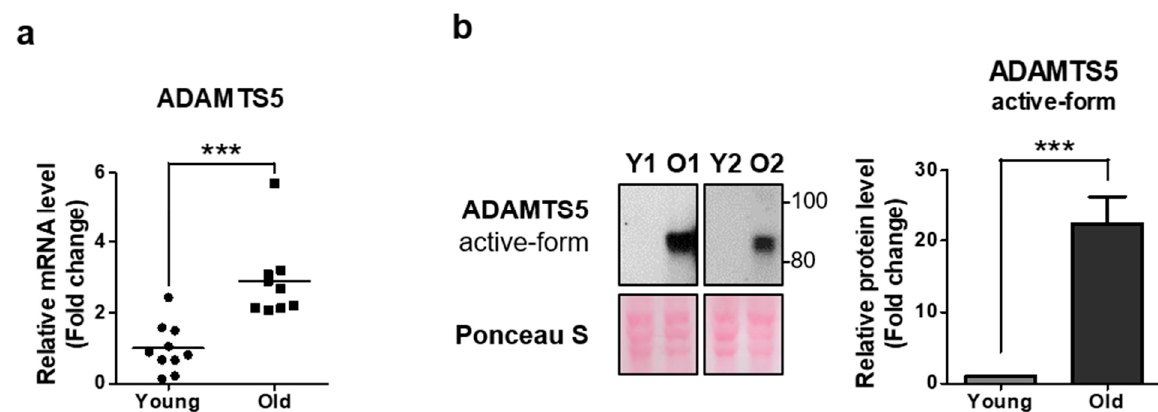
Figure 4. ADAMTS5 expression was increased in the dermis of elderly people. Total RNA was extracted in the dermis of young and aged sun-protected skin. Thereafter, the expression of ( a ) ADAMTS5 were measured by quantitative real-time PCR and normalized to the expression of 36B4 ( N = 19). ( b ) ADAMTS5 protein expression was analyzed by western blotting. We compared the sun-protected buttock dermis in young and old people. (Y; Young, O; Old) Ponceau S panel represents the loading control. Band intensity was analyzed using ImageJ and normalized to that of Ponceau S. Values represent the mean ± SEM of relative fold change ( N = 16). Statistical analyses were performed using Mann-Whitney U test. (*** p < 0.001).